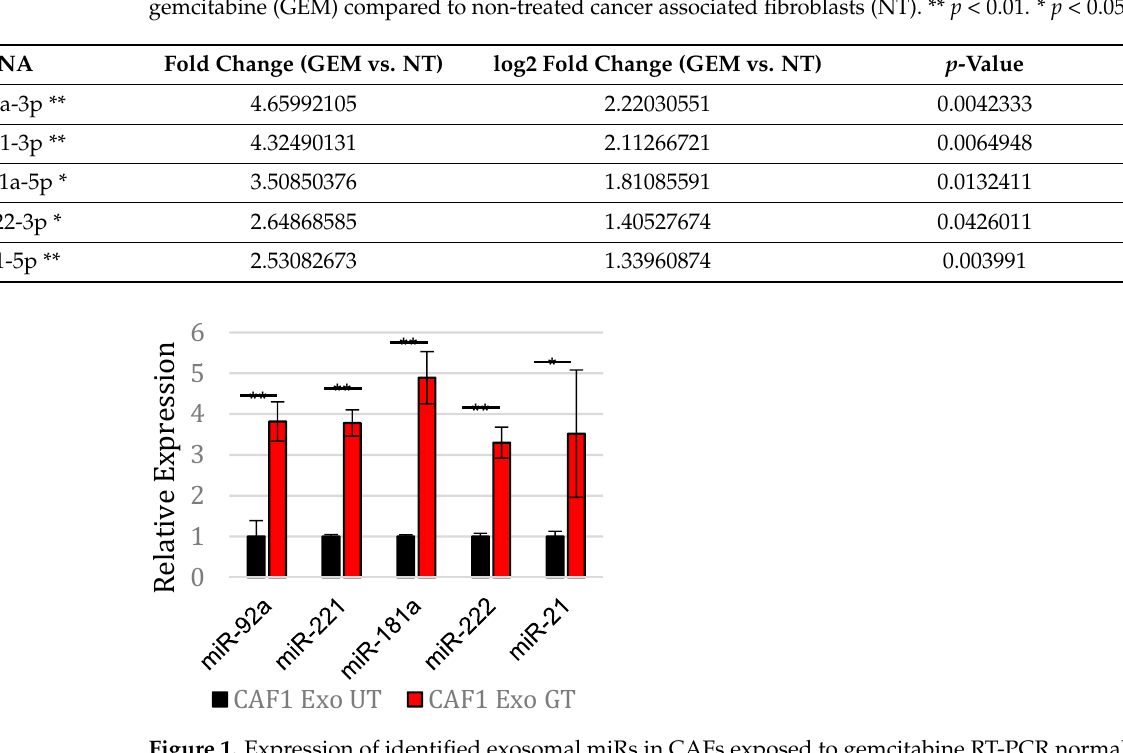
Figure 1. Expression of identified exosomal miRs in CAFs exposed to gemcitabine.RT-PCR normal- ized expression of miRs from exosomes in CAFs ex-posed to gemcitabine (Exo GT) and untreated CAFs (Exo UT). ** p < 0.01. * p < 0.05.